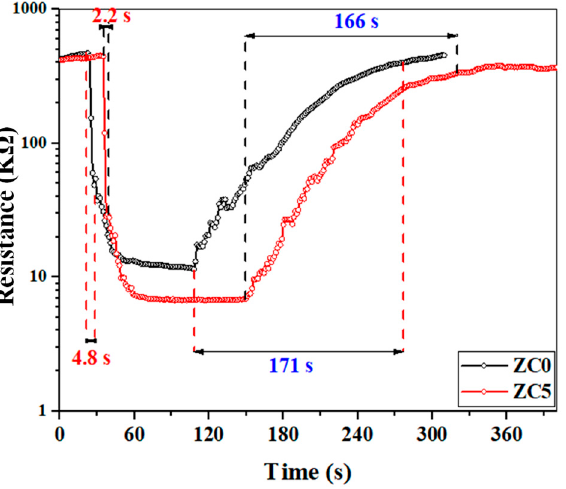
Figure 10. ( a ) Dynamic resistance curve of ZC5 gas sensors to various concentrations of ethanol at 350 °C. ( b ) Calibration curves of pristine and CuO-decorated ZnO gas sensors to 25–500 ppm ethanol at 350 °C.